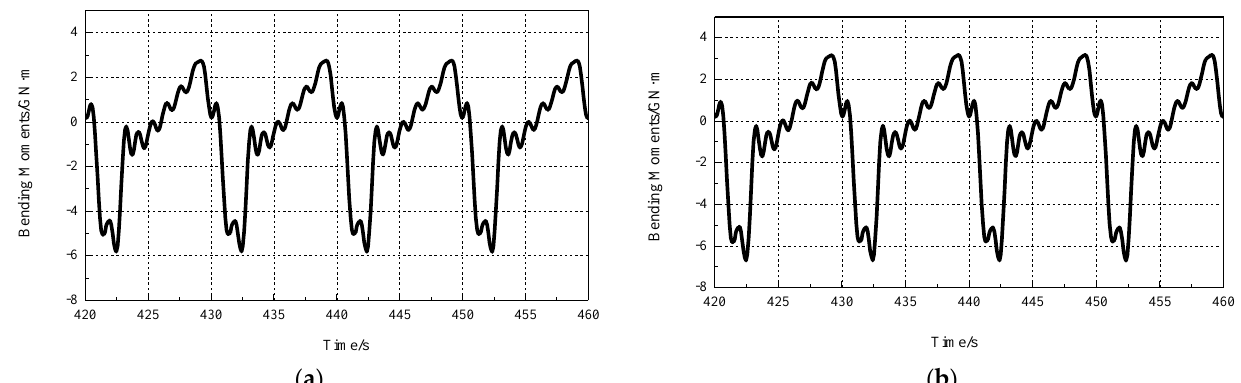
Figure 8. Time histories of bending moments ( U = 5 kn). ( a ) Without slamming effect; ( b ) With slamming effect.